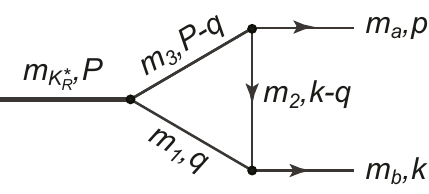
Figure 6 . Momenta and mass assignment in the decay process of the K (cid:3)